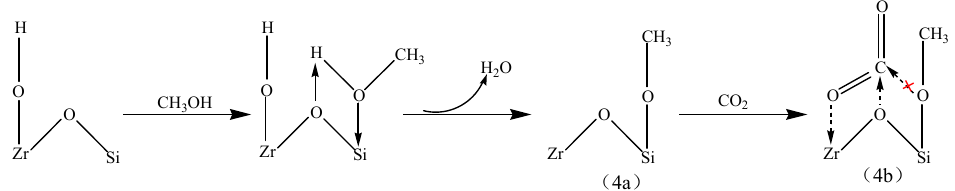
Scheme 4. Synthetic routes for the m-CH 3 OC(O)O-Zr(Si) on the Zr/SBA-15 catalyst.